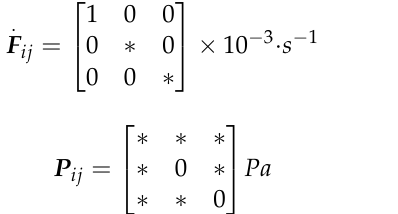
Table 2. Mechanical properties of multiphase (ferrite and martensite) were adopted from [37] for simulation modeling. Parameter Symbol Ferrite Martensite Unit First elastic stiffness constant with C 11 233.3 417.4 GPa normal strain Second elastic stiffness constant C 12 135.5 242.4 GPa with normal strain First elastic stiffness constant with C 44 128.0 shear strain Initial shear resistance on [111] S 0 [111] Saturation shear resistance on [111] S ∞ [111] Initial shear resistance on [112] Saturation shear resistance on [112] S ∞ [112] Interaction hardening parameter Stress exponent Curve fitting